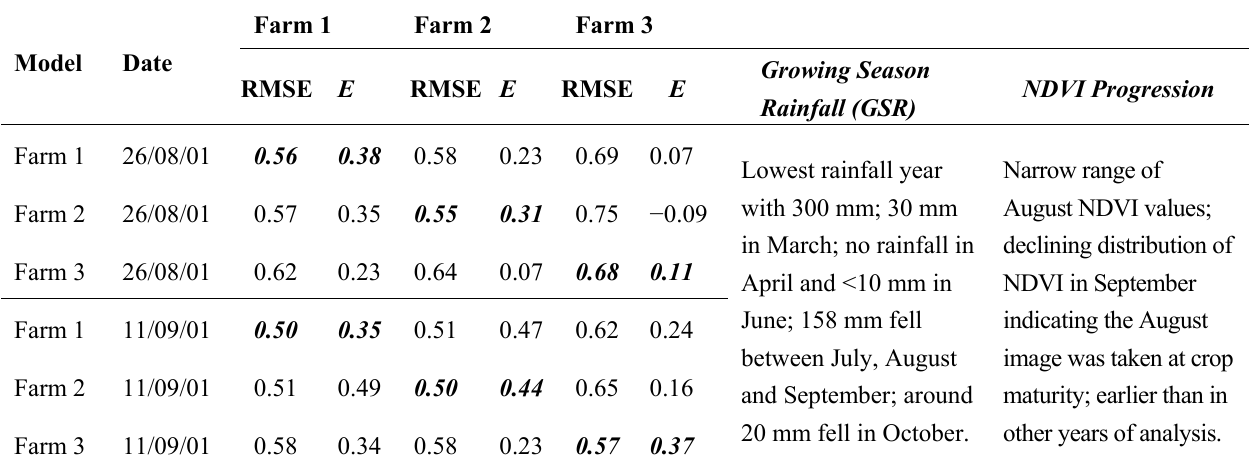
Table 6. Model and yield prediction efficiency criteria for 2001 Landsat imagery-Root Mean Square Error (RMSE) and the Nash-Sutcliffe Efficiency Criteria ( E ). Values in bold italics represent efficiency criteria for the calibration models. Descriptions of 2001 Growing season rainfall, NDVI progression and interpretations of results.